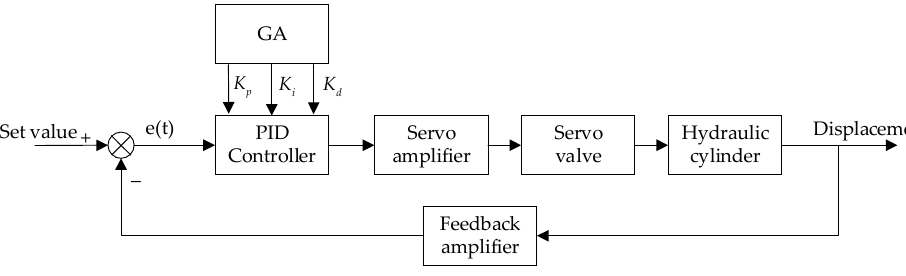
Figure 5. PID Controller optimized by genetic algorithm.